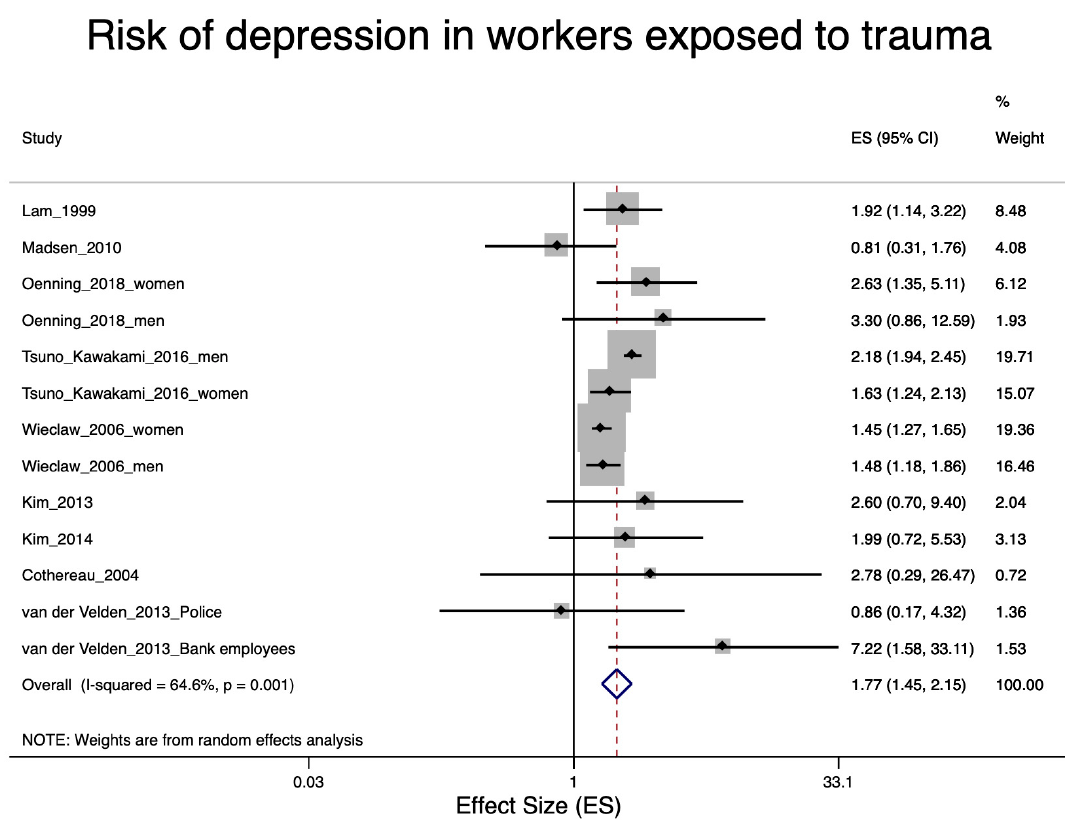
Figure 6. Forest plot of workers exposed to occupational trauma and the estimates of effect size (ES) for depression. Note: unadjusted PR for Cothereau et al., 2004 [56].